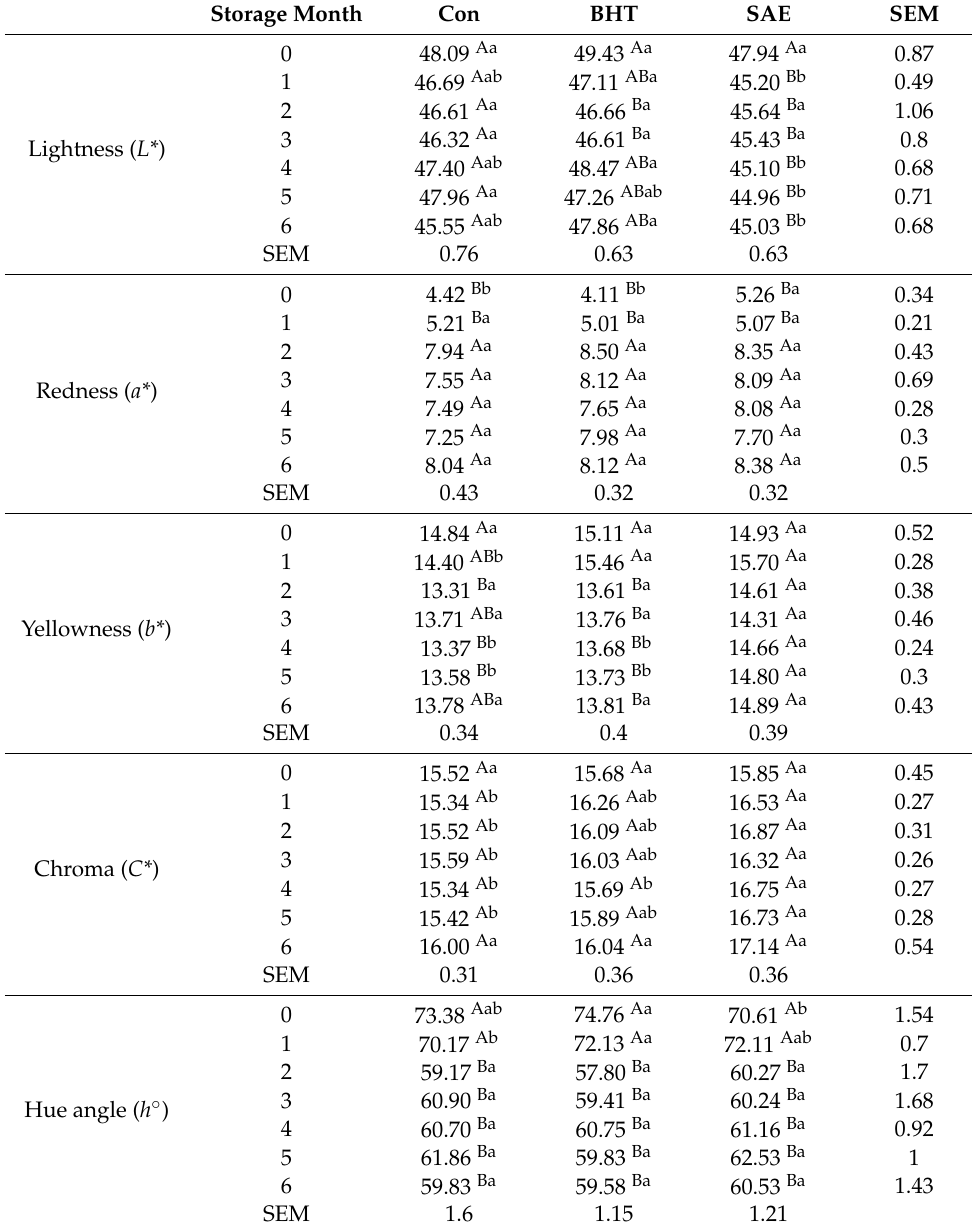
Table 3. Color of cooked ground beef with different antioxidant additives at frozen